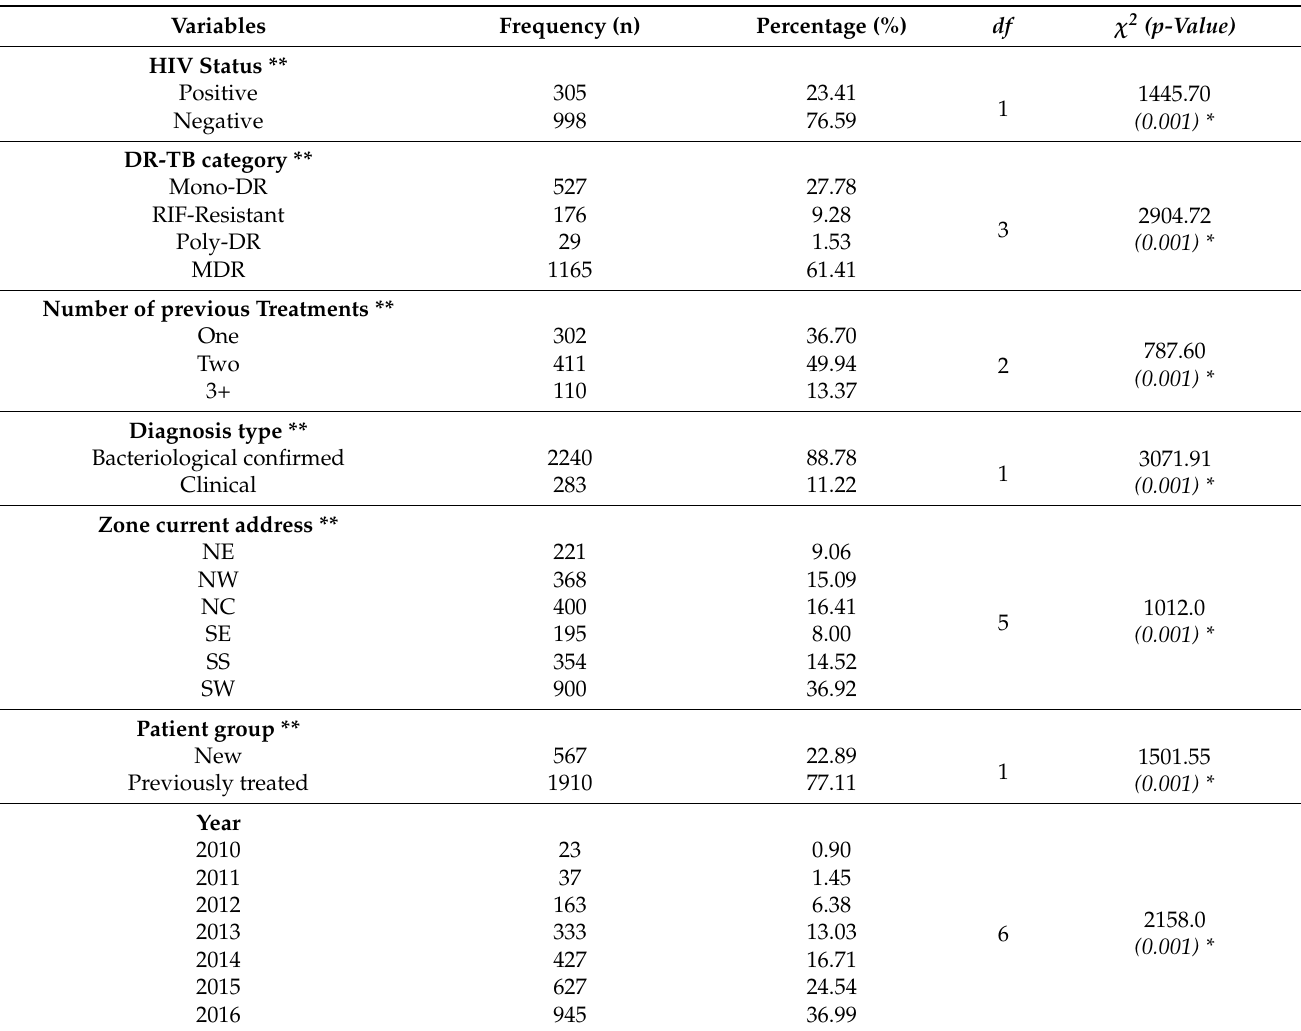
Table 2. Association of gender and DR-TB cases in Nigeria (2010 – 2016) ( n = 2555) (bivariate). Variables